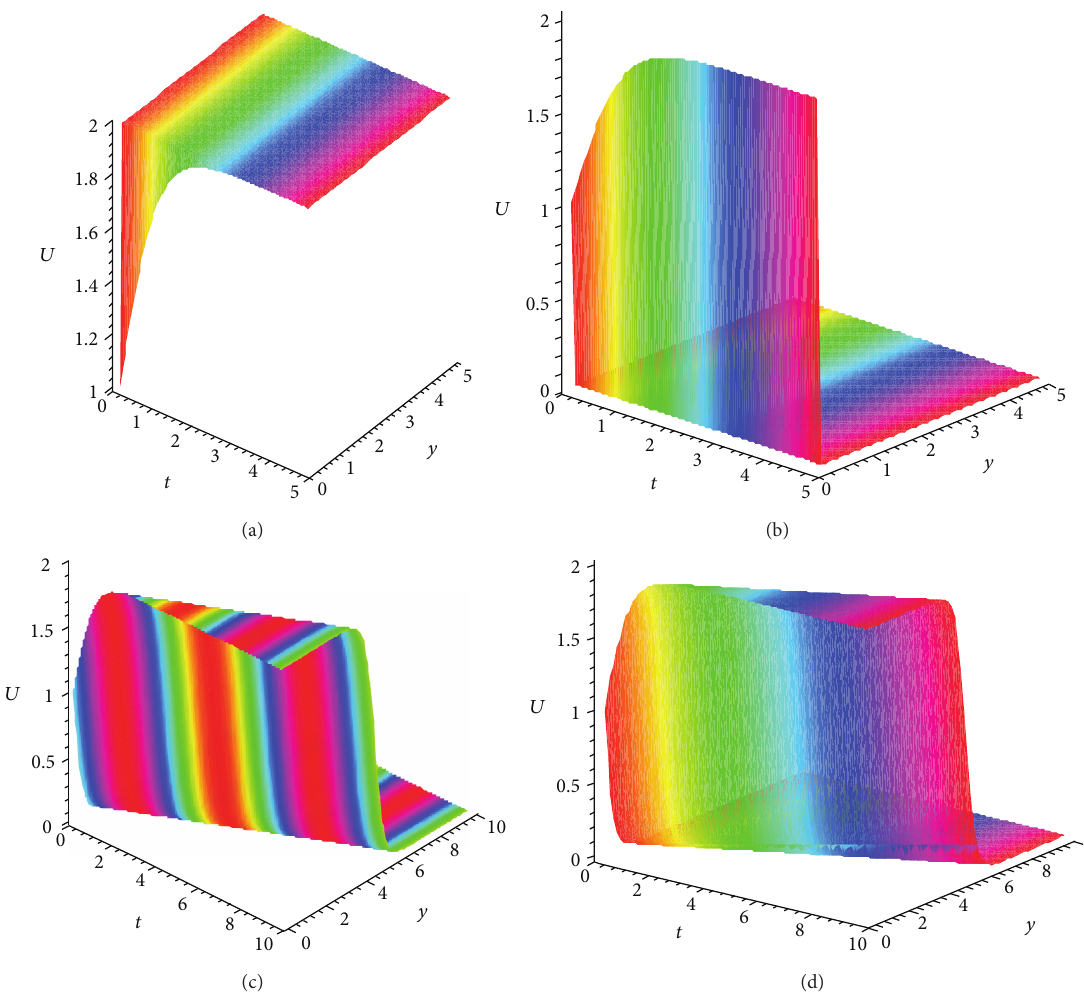
Figure 1: Evolutional behavior of 𝑈 2 describes kink soliton solution with linear moving boundary 𝑠(𝑡) = V 𝑡 and 𝜎 = 𝜇 = −1 , 𝑎 0 = 𝑘 = 1 : (a) V = 100 ; (b) V = −100 ; (c) V = 0.001 ; (d) V = −0.001